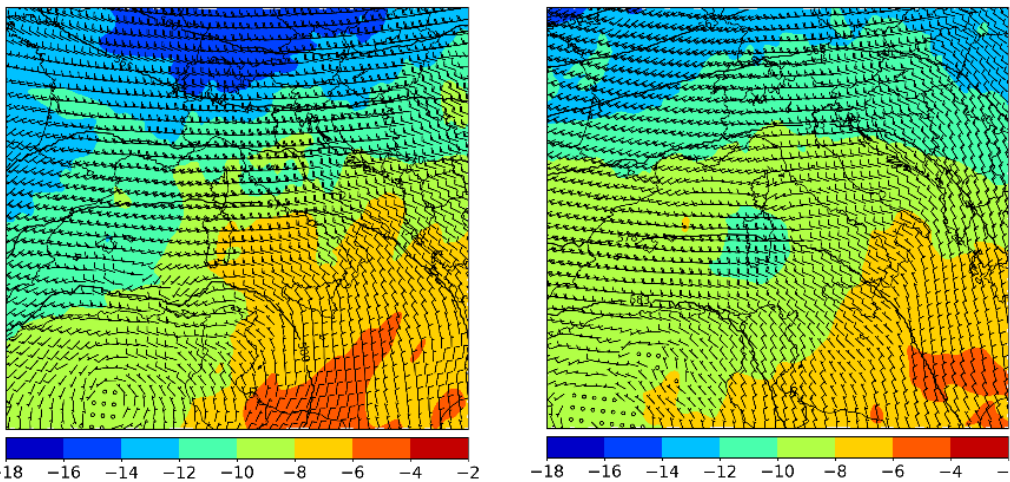
Figure 8. European Centre for Medium-Range Weather Forecasts—High Resolution Forecast (ECMWF-HRES) analysis: 500 hPa temperature (°C), wind (barbs), and geopotential height (dm, contours) on 7 July 2019 ( left panel ) and 6 August 2019 ( right panel ) at 12:00 UTC.